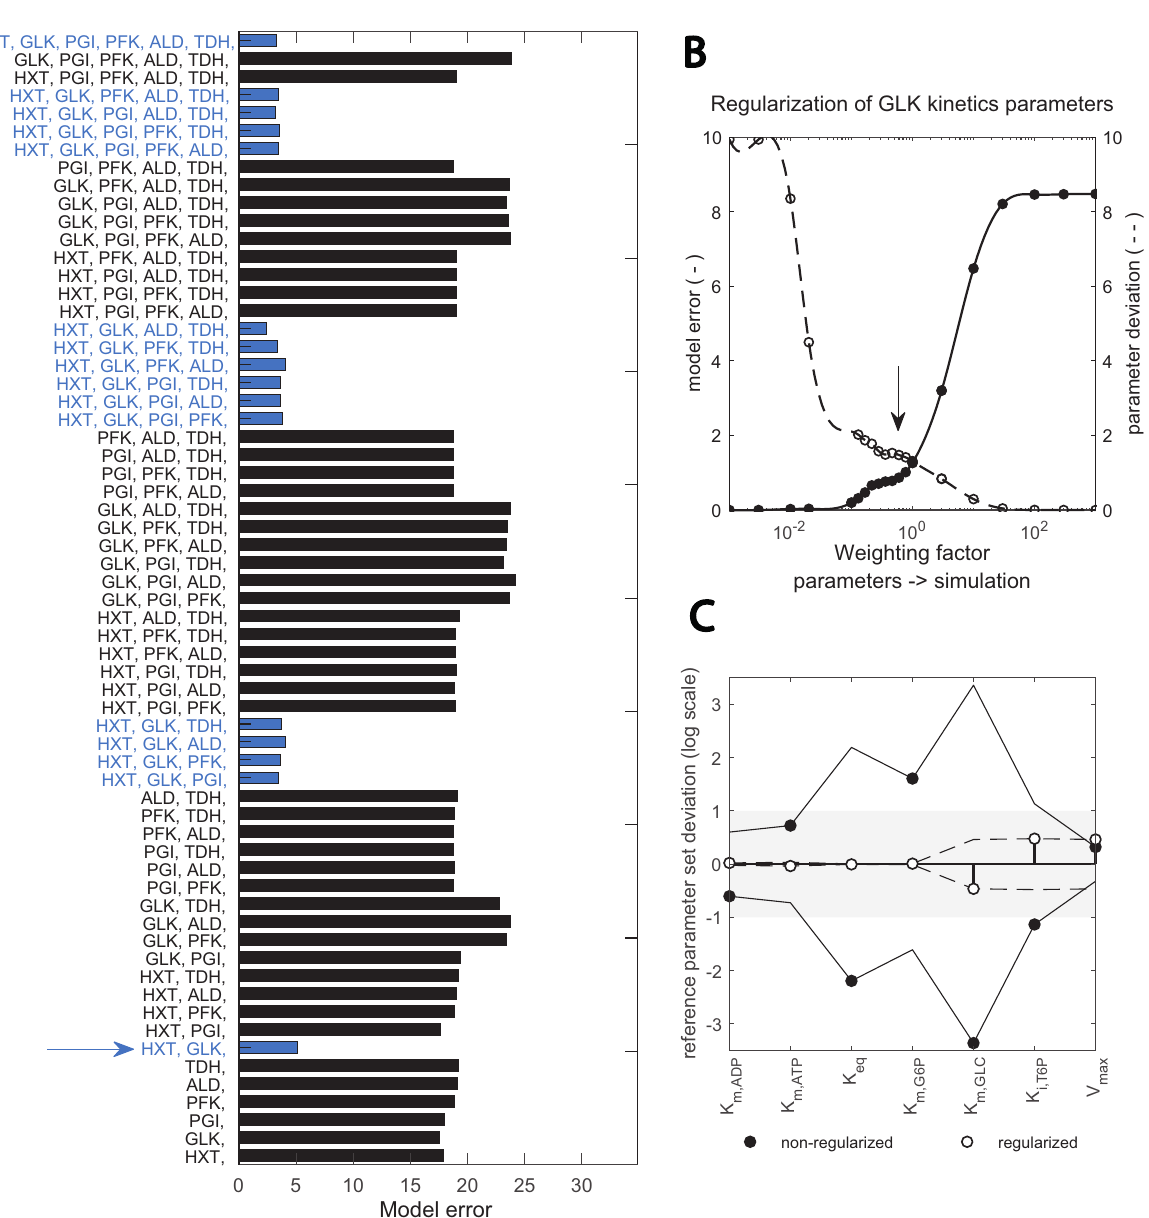
Figure 5. Two-step, scaled optimization approach results: ( A ) fitting the data with different subsets of enzyme parameters; bars show the error between simulation and best fit with the respective combination (upper x-axis). Blue bars highlight the combinations containing the two enzymes HXT and GLK. Red lines show the number of enzymes; ( B ) implementation of a regularization factor on the estimation of GLK kinetic parameters; the dashed and continuous line; show model and parameter error, respectively. The arrow indicates the chosen regularization factor. Parameters are regularized such that the data is still well reproduced (see Supplementary Figures S3 and S4). ( C ) change in key GLK parameters identified upon regularization; the deviation between the estimated parameter and the initial value taken from (bioRxiv2022) is shown in the y-axis (in logarithmic scale). Black and empty circles show the estimates prior and post regularization when parameter dependencies are minimized. The x-axis shows specific